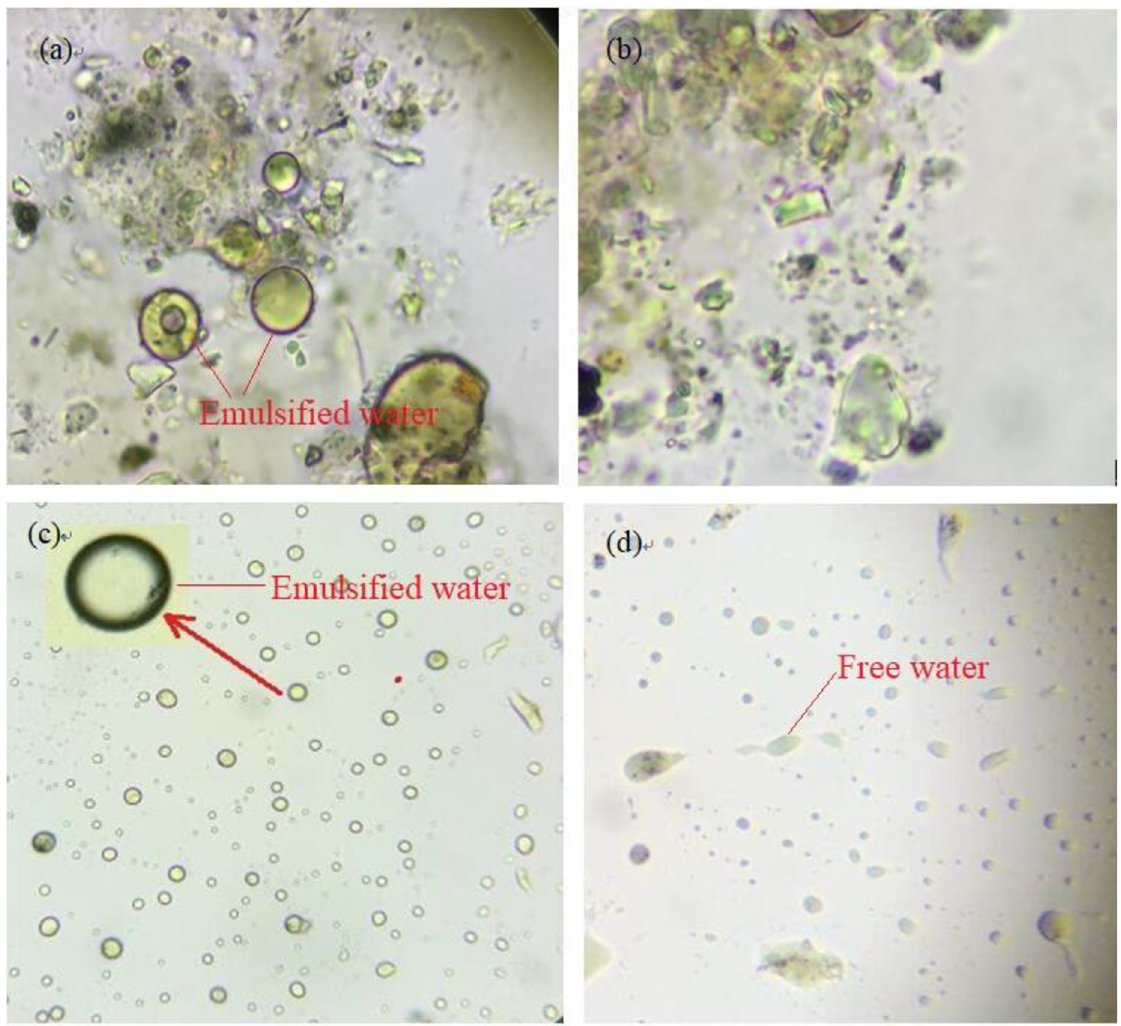
Fig 5. The status of the water in the crude oily sludge (a); the water in the oily sludge after adding OSM (b); the status of the water in the original oily sludge leachate (c); and the water in the oily sludge leaching solution after adding OSM